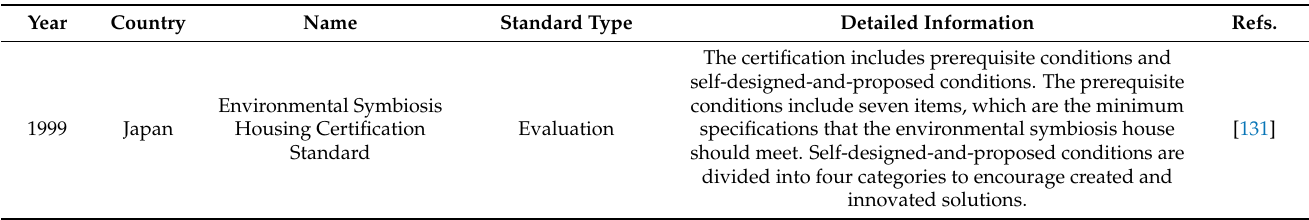
Table 5. Healthy building standards and guidelines